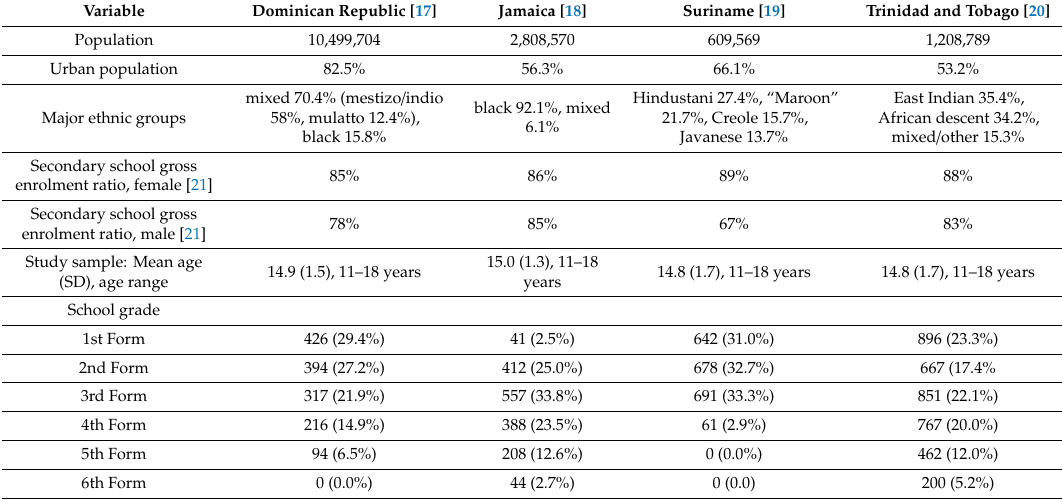
Table 1. Study context